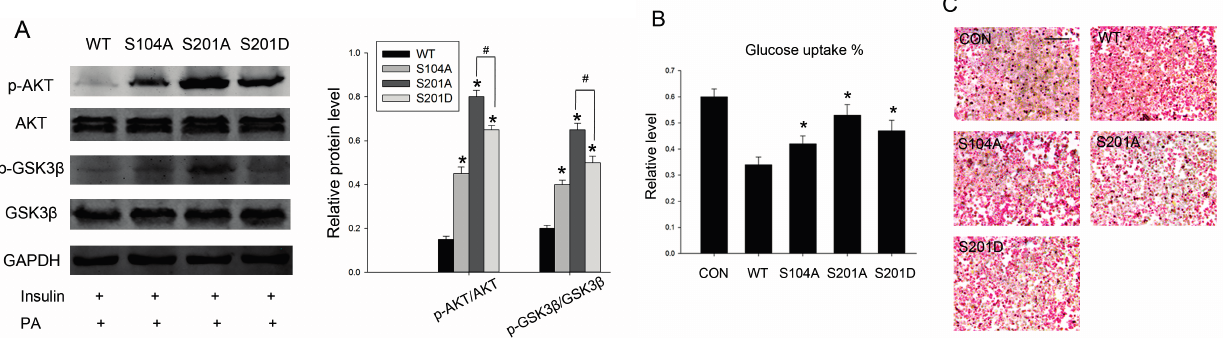
Figure 4. Intervention PTP1B O -GlcNAcylation can recover insulin sensitivity and improve lipid metabolism. Cells were first transfected with wild-type and different site-directed mutations and treated with 0.2 mM palmitate, then incubated for 20 min with 100 nM insulin. ( A ) The protein levels and phosphorylation of Akt and GSK3 β were measured by western blot analysis; ( B ) 50 μ L of medium was sampled for measurement of glucose concentration using a Glucose Colorimetric/Fluorometric Assay Kit. The primary medium was used as the control; ( C ) Lipid deposition was determined by Oil red O staining. Scale bars 50 μ m. Data show mean ± SD of three independent experiments. * and # mean p < 0.05, significantly different from respective